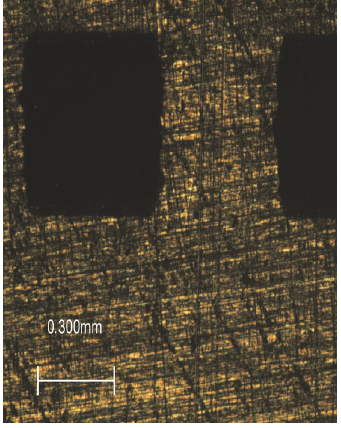
Figure 3: LST microsurface